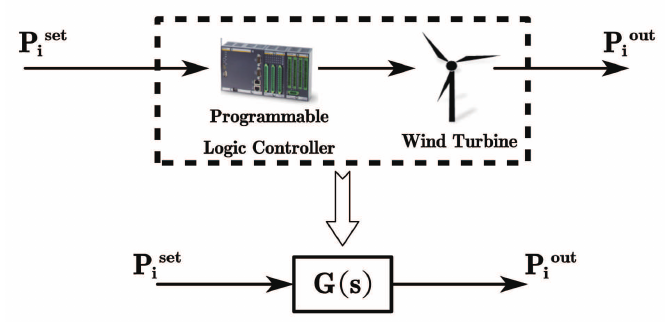
Figure 1. Wind turbine power-tracking dynamic